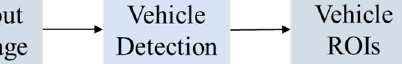
Figure 2. Flowchart of the typical MMR system.